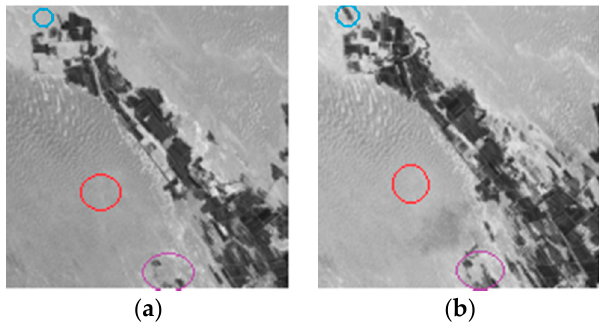
Figure 10. Gurbantunggut data set: ( a ) Image acquired in July 1999; ( b ) Image acquired in July 2007.